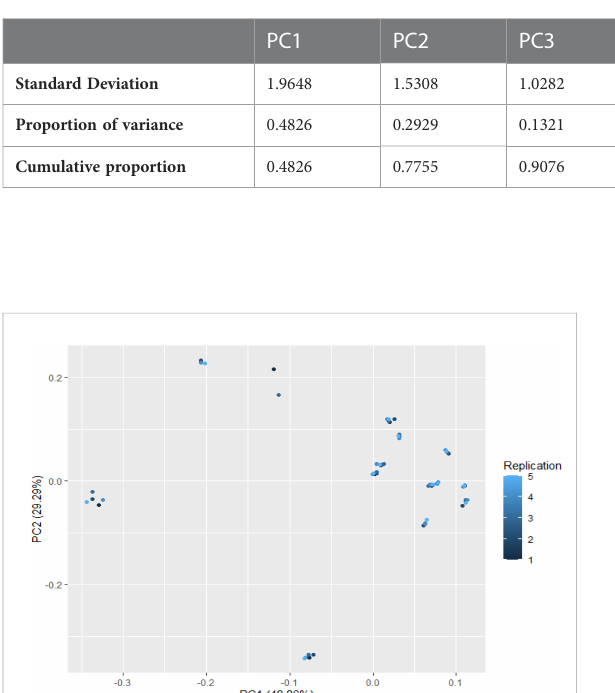
FIGURE 7 Scatter plot of fi rst two principal components PC1 and PC2 with the replication of 1 to 5 presented. This plot shows variability in the distribution pattern of metabolites.